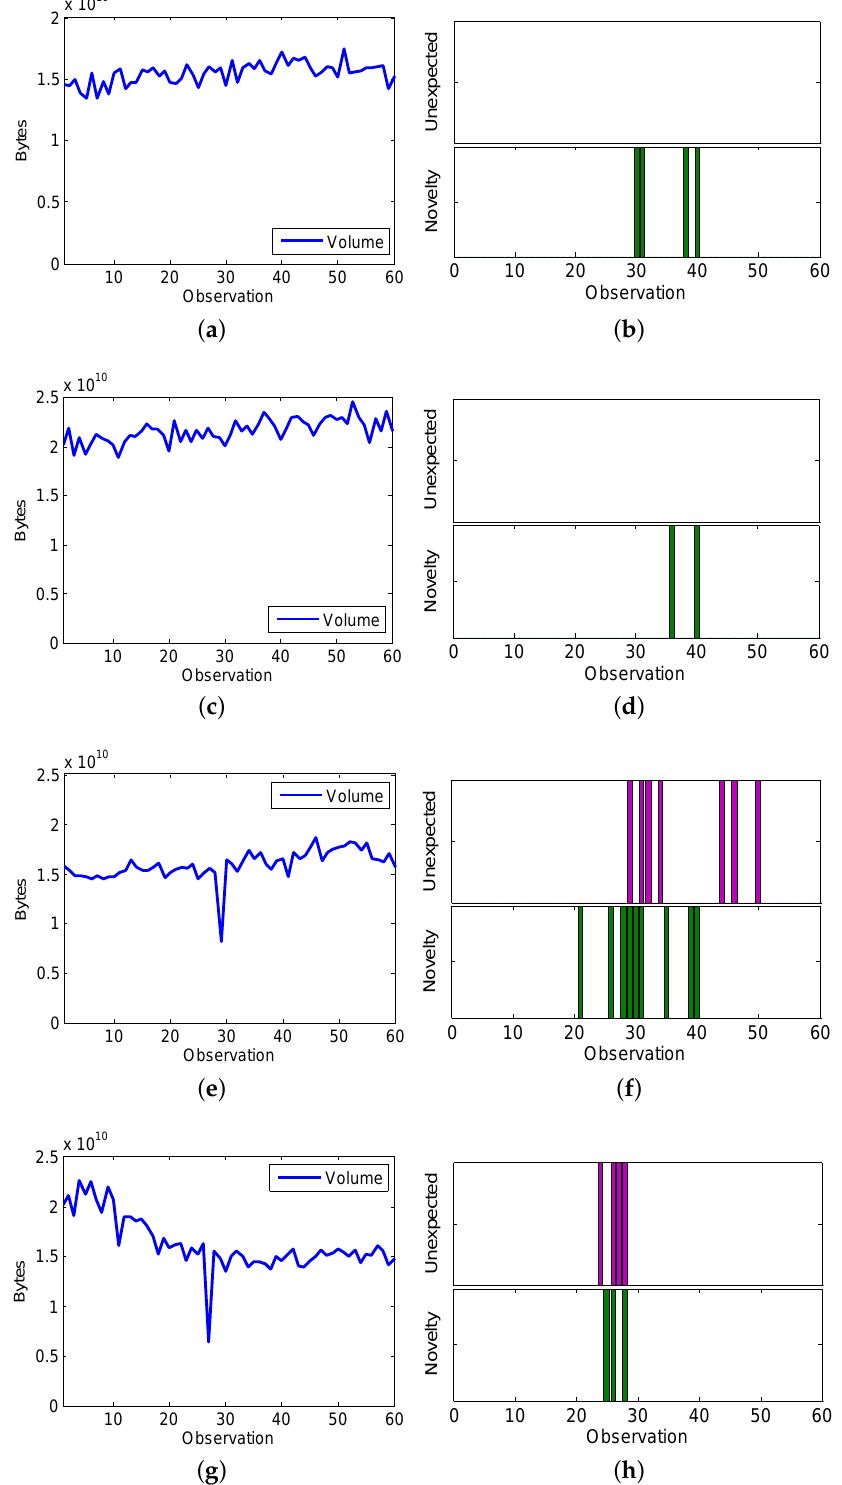
Figure 8. Evolution of observations, thresholding and novelty detection on CAIDA’16 monthly. ( a ) Observations (January); ( b ) Symptoms (January); ( c ) Observations (February); ( d ) Symptoms (February); ( e ) Observations (March); ( f ) Symptoms (March); ( g ) Observations (April); ( h ) Symptoms